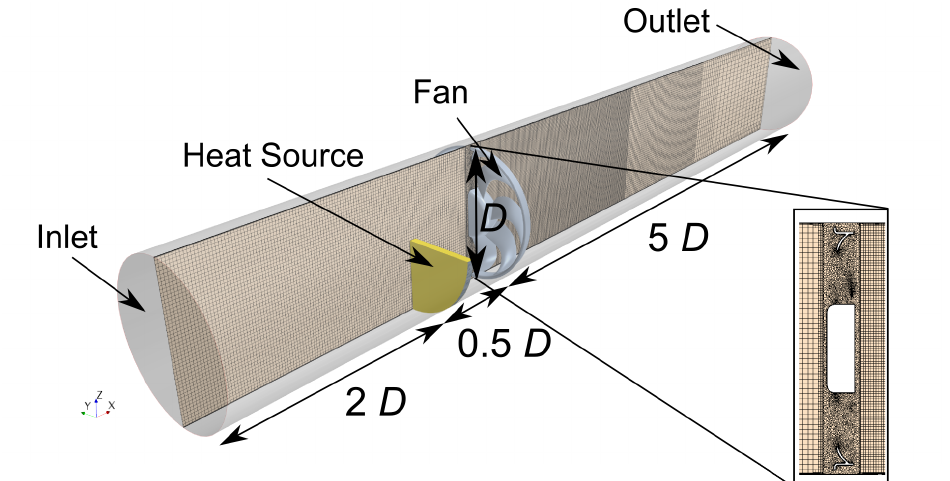
Figure 1. Computational domain for the pipe